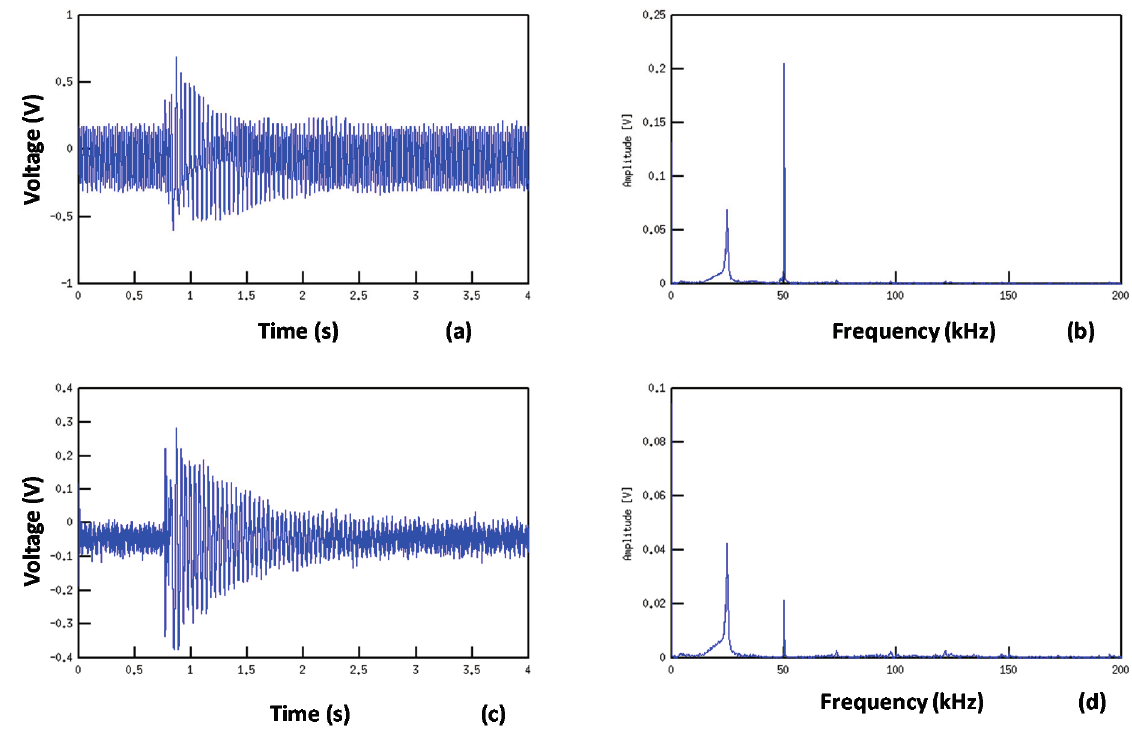
Figure 11. Temporal filter response: ( a ) Non filtred temporal signal; ( b ) Spectral response of the signal. Notice the amplitude of the 50 Hz; ( c ) Filtred temporal signal using the 50 Hz notch filter; ( d ) Spectral response of the filtered signal. Notice the reduction of the 50 Hz noise.